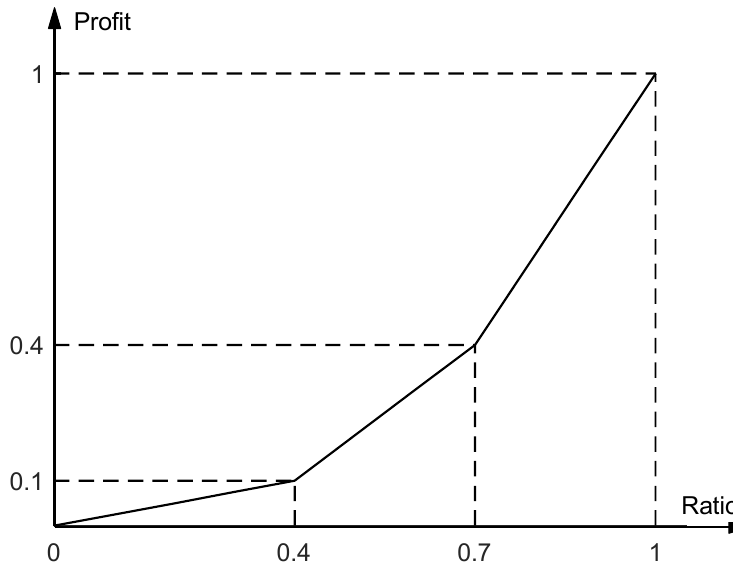
Figure 2. The piecewise linear function for profit calculation.